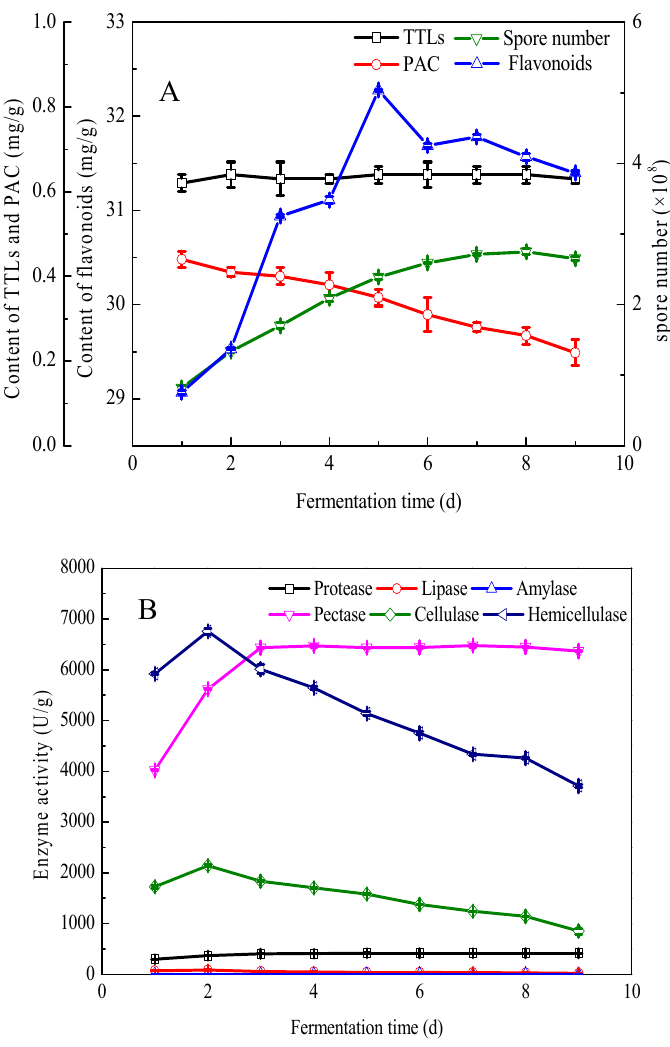
Figure 6. Effects of fermentation time (d) on different indexes: ( A ) spore number and ( B ) flavonoid content.